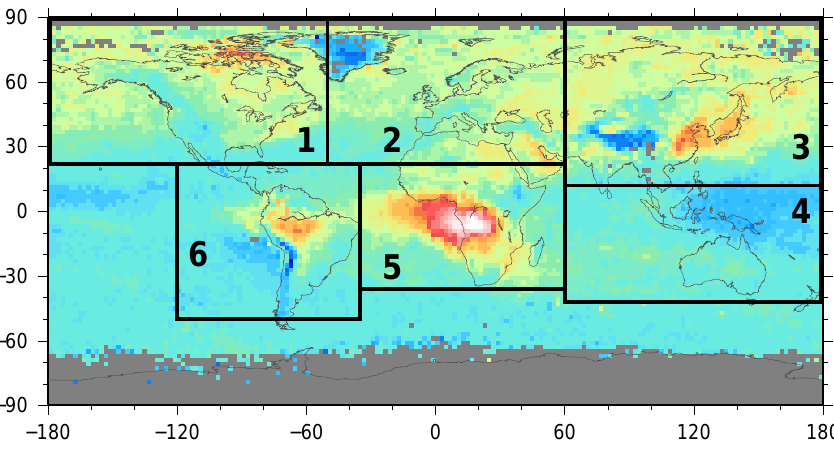
Figure 6. Main domains of CO emissions considered for the regional validation of the proposed method dealing with the validation of CO TOTCOL ANALYSES.